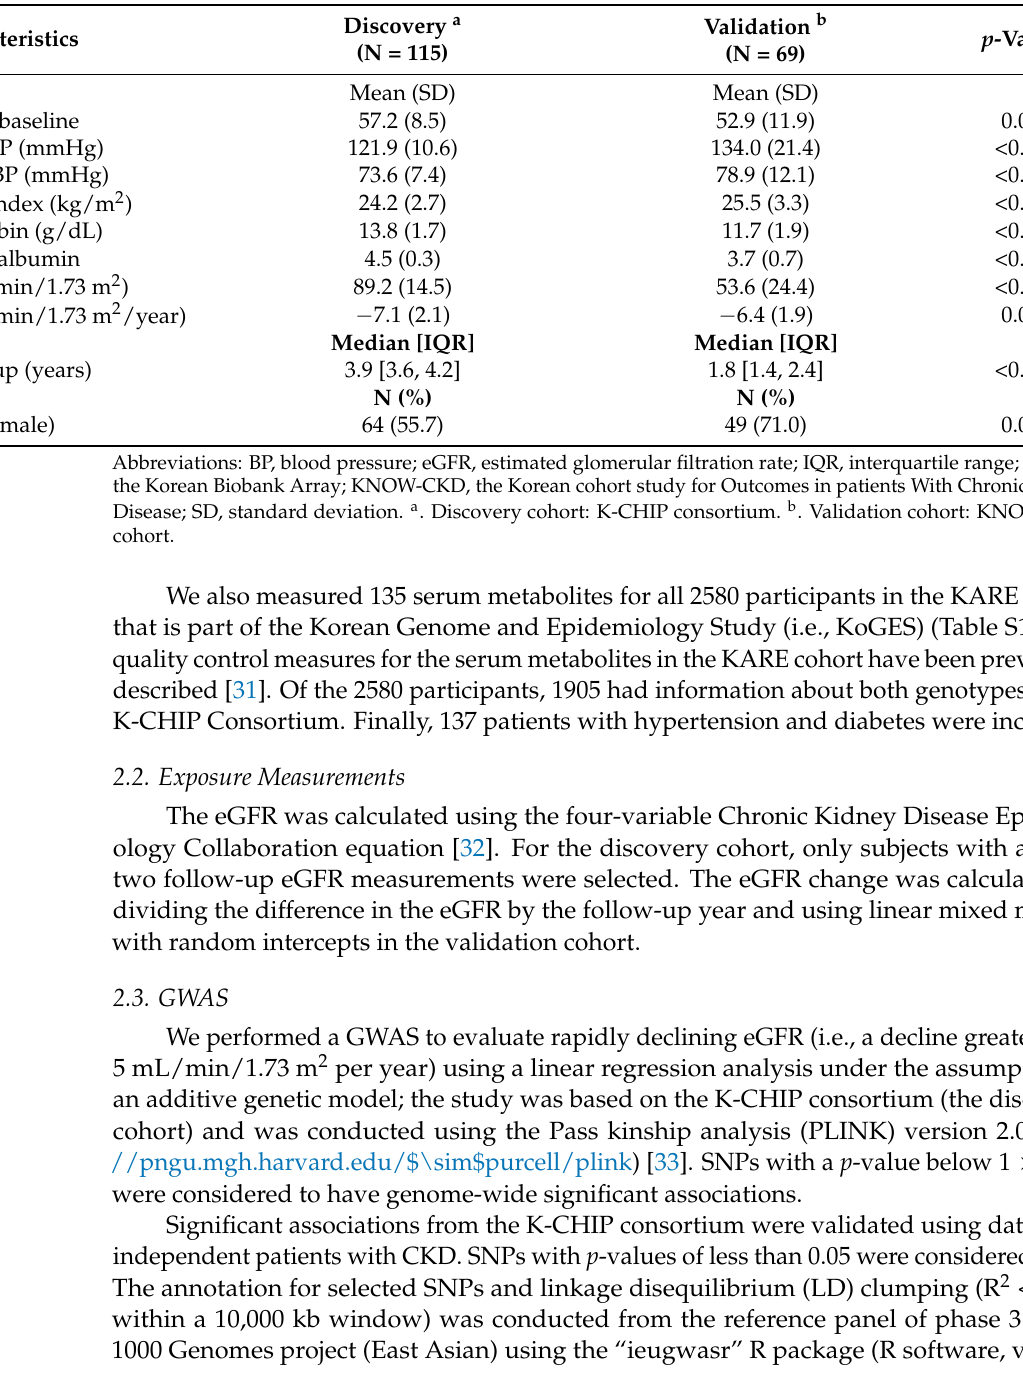
Table 1. General characteristics of the participants in the discovery and the validation